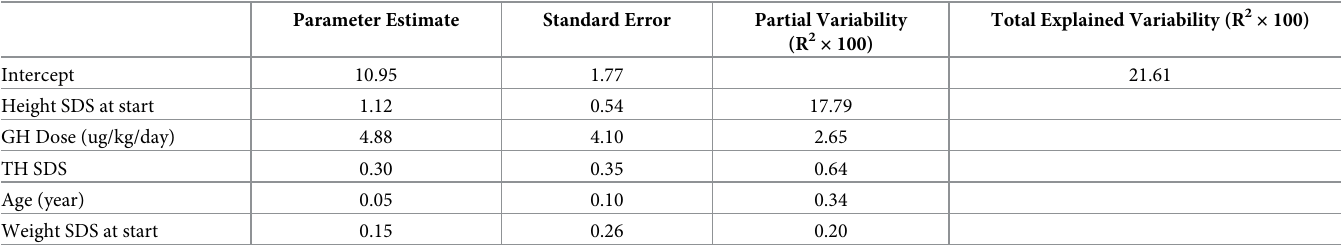
Table 3. Regression equation variables for prediction of the growth response to GH treatment for the first year in short children born SGA (n =